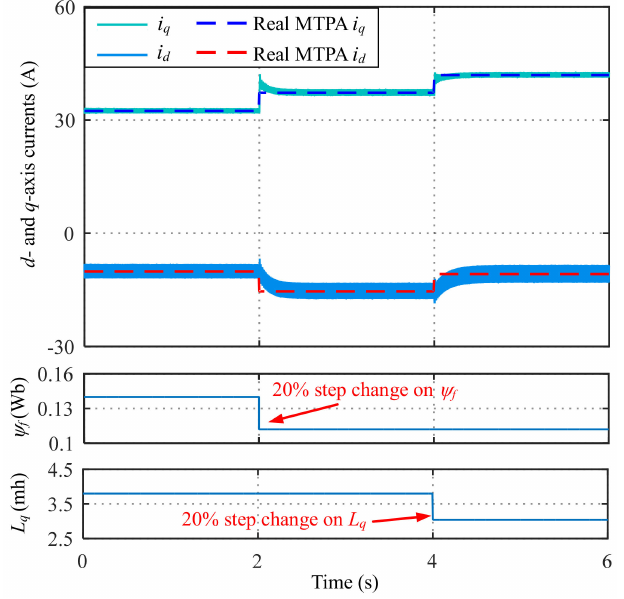
Figure 5. Simulation results of the proposed method against motor parameter variations under a load torque of 30 N ·